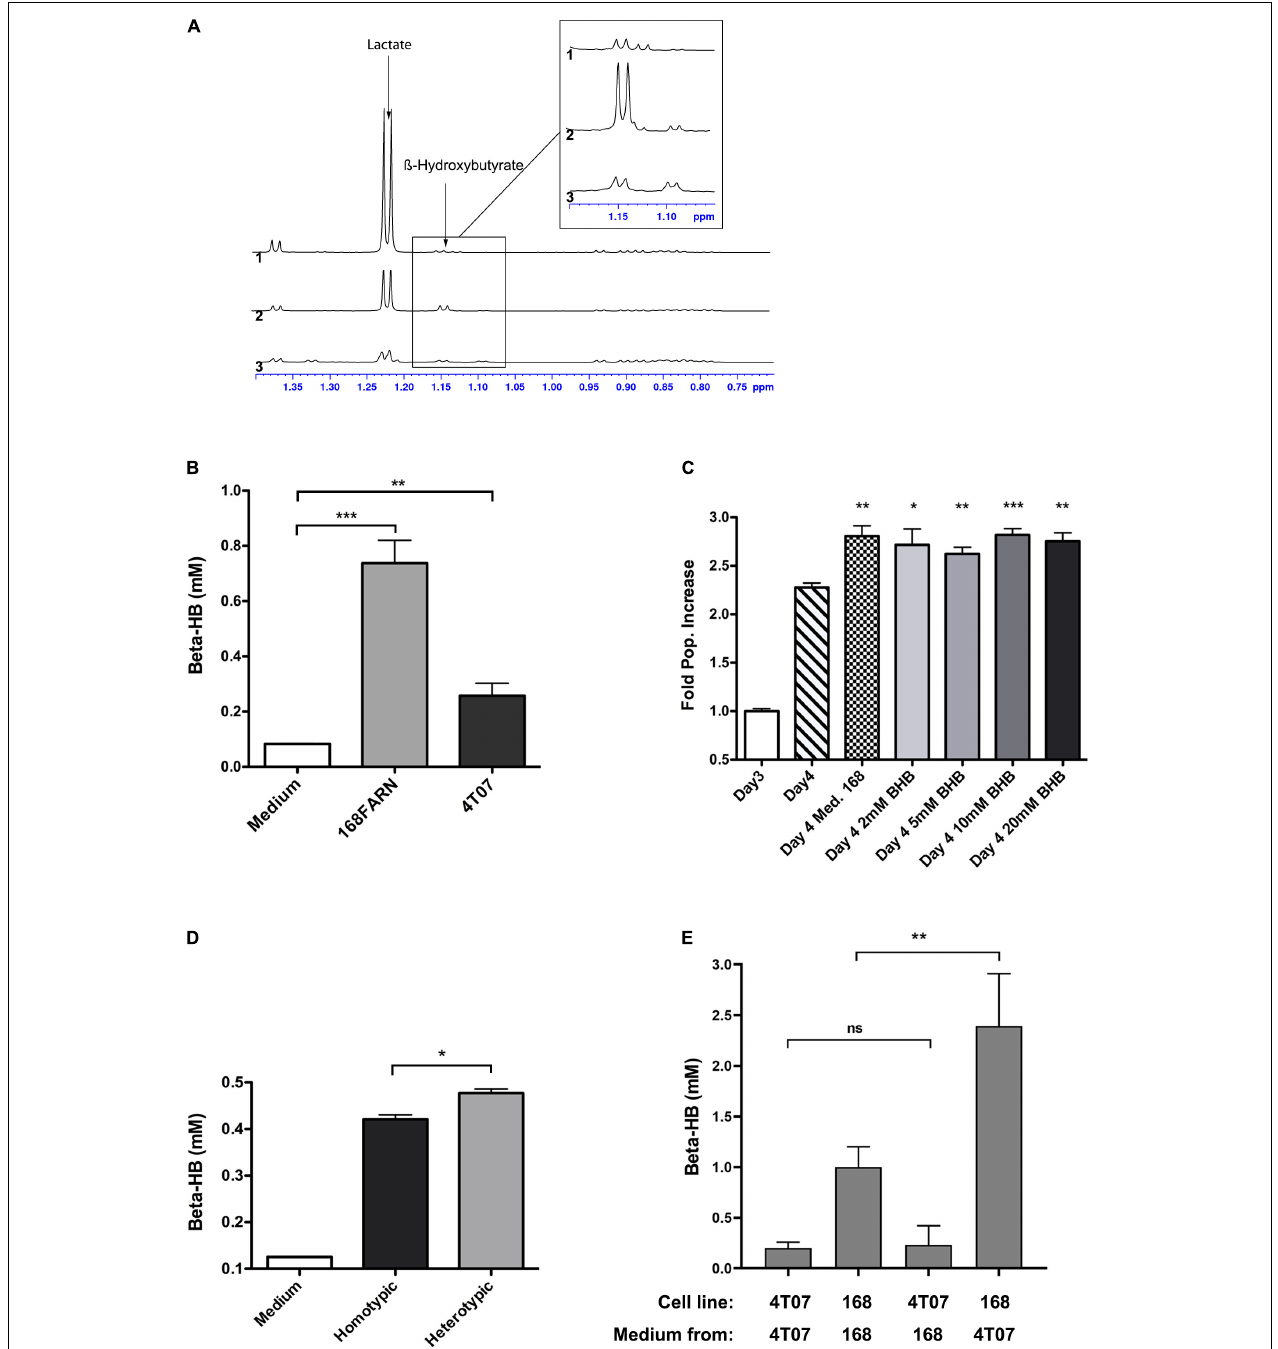
FIGURE 5 | Identification of soluble metabolites altering the heterotypic growth dynamics. (A) Superimposition of the high-field region of representative 1D proton NMR spectra recorded at 700 MHz, 293 K and pH 7 on samples of culture media collected after growing 40T7 cells (1) or 168FARN cells (2) for 3 days or of fresh cell culture medium (3). The arrows indicate the characteristic resonance of lactate and β -hydroxybutyrate. The insert displays a zoom in this spectral region, revealing the H-alpha resonance of the β -hydroxybutyrate. For all spectra, peak intensities have been normalized on the intensity of the DSS resonance added as internal reference. (B) Concentration of β -hydroxybutyrate from fresh medium and from conditioned medium from 168FARN or 4T07 was quantified. (C) Commercially available β -hydroxybutyrate at indicated concentrations was added to 4T07 cell culture at day 3 an the growth allowed to proceed for an additional 24 h. All points are compared to Day 4 point. (D) 168FARN alone (homotypic) or in 1:1 co-culture with 4T01 cells were grown for 4 days and extracellular β -hydroxybutyrate was measured enzymatically as in Figure 4B . (E) 168FARN and 4T07 cells were cultured individually for 3 days. The medium was then replaced by the homotypic or heterotypic conditioned one, as indicated, and the culture allowed to continue for an additional 24 h. The β -hydroxybutyrate concentration was quantified at day 4. ns, not significant; * p < 0.05, ** p < 0.01, *** p < 0.001.